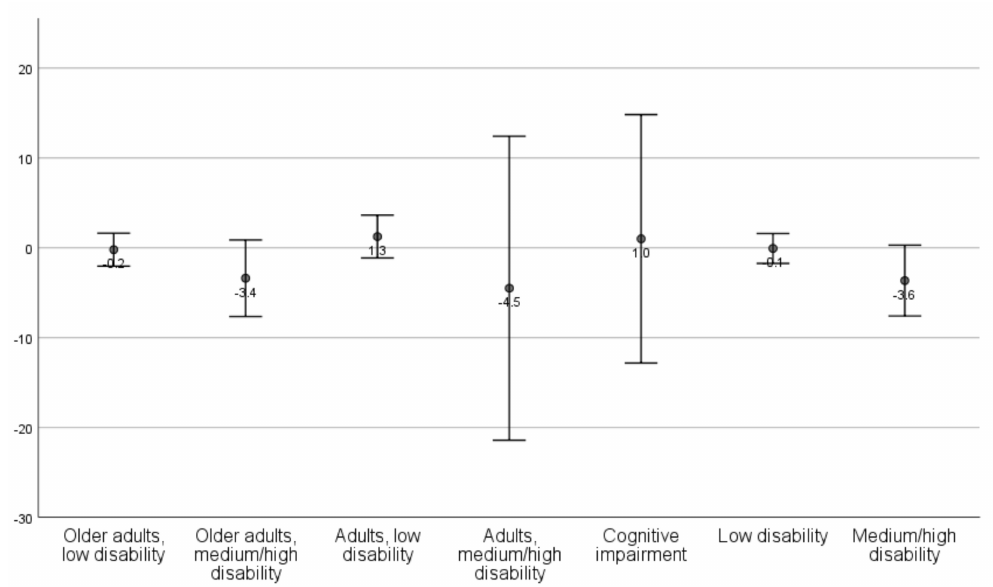
Figure 3. Mean changes (dots) with standard deviation (lines) in concerns about falling, per client profile and aggregated client profiles. Values > 0 indicates decline (i.e., increased concern about falling) from T1 to T4.